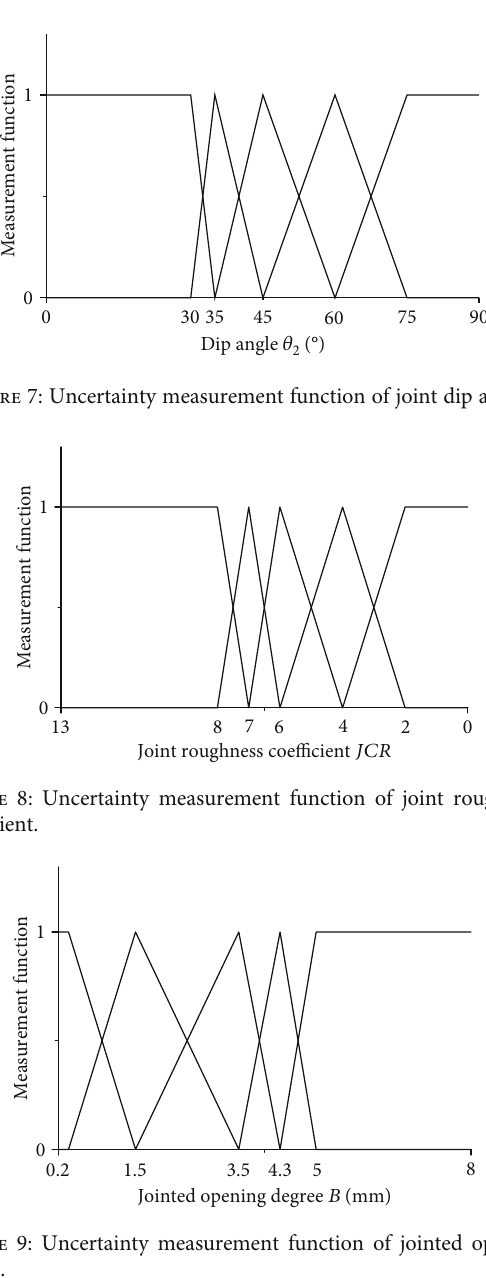
Figure 6: Uncertainty measurement function of joint strike